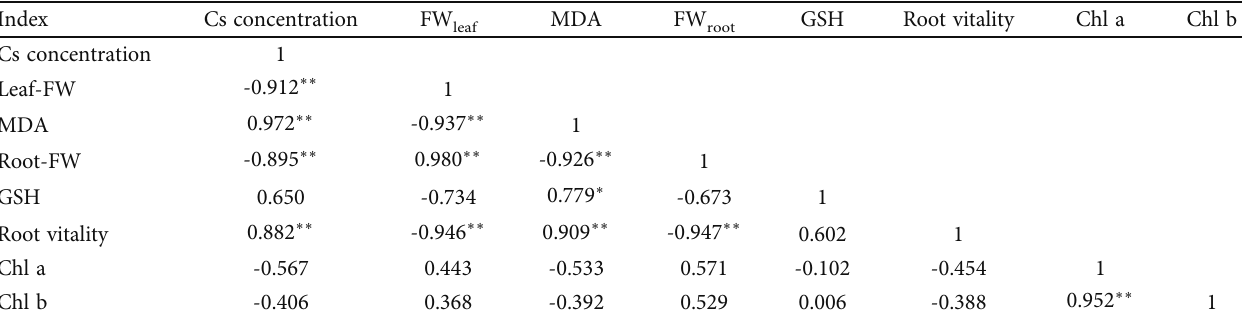
Table 2: Correlation analysis between Cs treatment concentrations and growth parameters and physiological